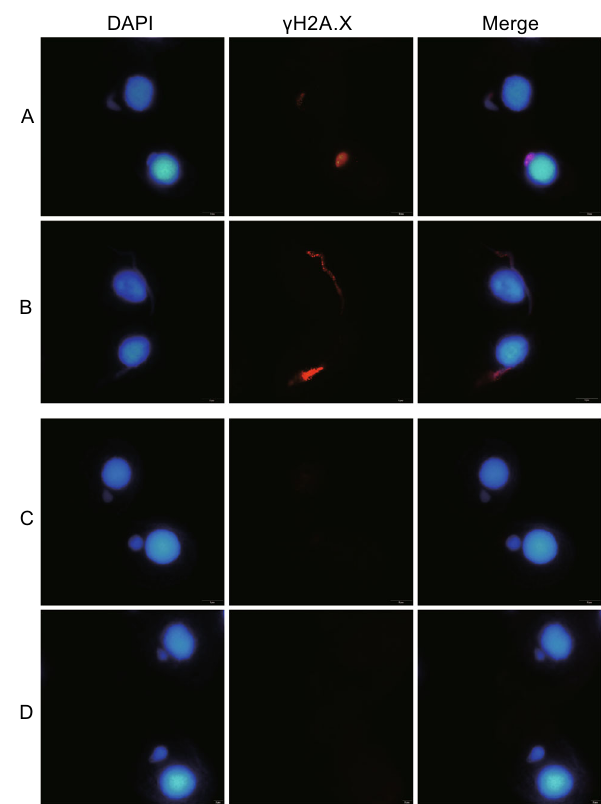
Figure 5. Immunostaining of wildtype and CYC2 KO strains. (A) Gamma-H2AX signals occupied the whole wild type micronu- clei before crescent stage. (B) Gamma-H2AX signals occupied the whole wild type meiotic micronuclei during crescent stage. (C and D) There were no gamma-H2AX signals in CYC2 KO micronuclei, which could not elongate fully during